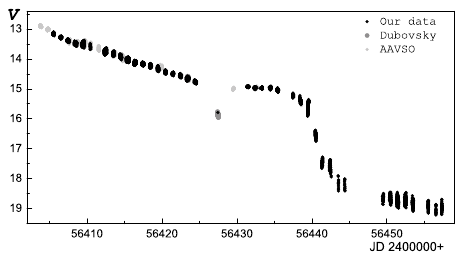
Figure 1: V light curve of superoutburst.